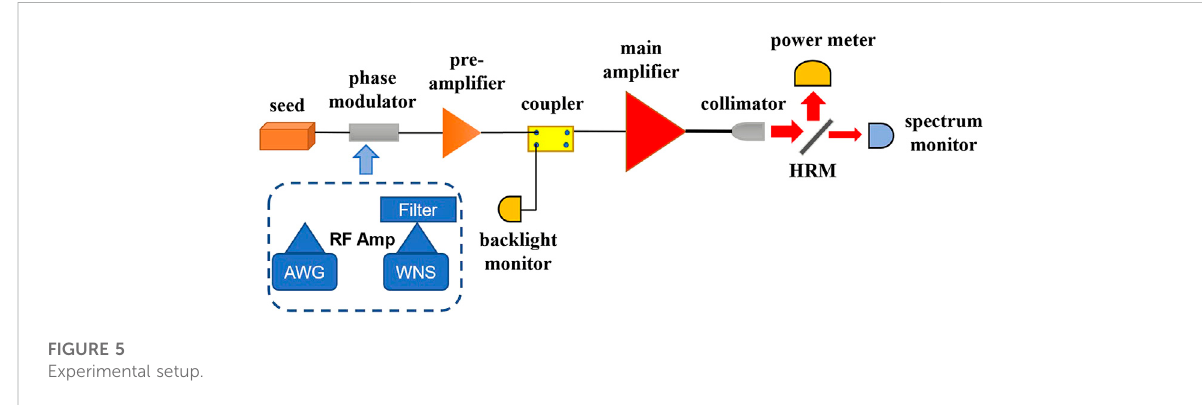
FIGURE 5 Experimental setup.